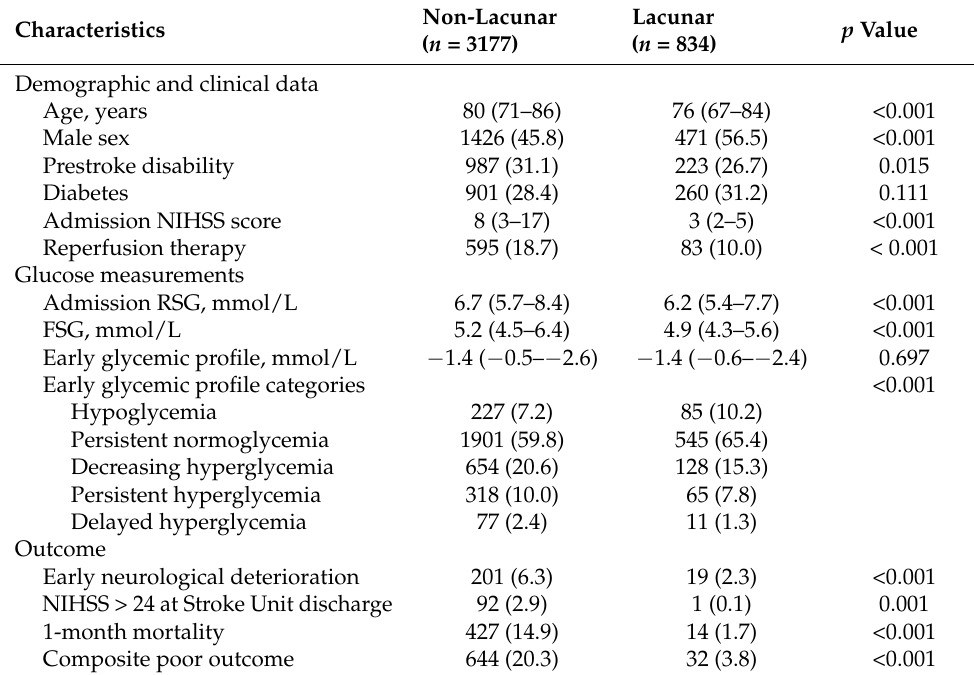
Table 1. Baseline characteristics and outcomes by ischemic stroke subtype.